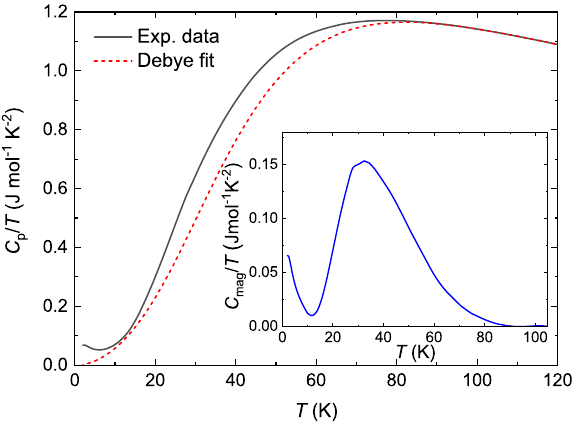
Fig. 3 Speci fi c heat. Zero- fi eld speci fi c heat of Ba 2 LuMoO 6 as function of temperature (black line) and the estimated lattice speci fi c heat from Debye fi ts above 90 K (red dash line). No lambda anomalies indicative of magnetic order are observed down to 2 K. Moreover, there is no broad peak in speci fi c heat associated with possible quadrupolar order in related materials. Inset: Estimated magnetic speci fi c heat of Ba 2 LuMoO 6 . A broad maximum is observed around 30